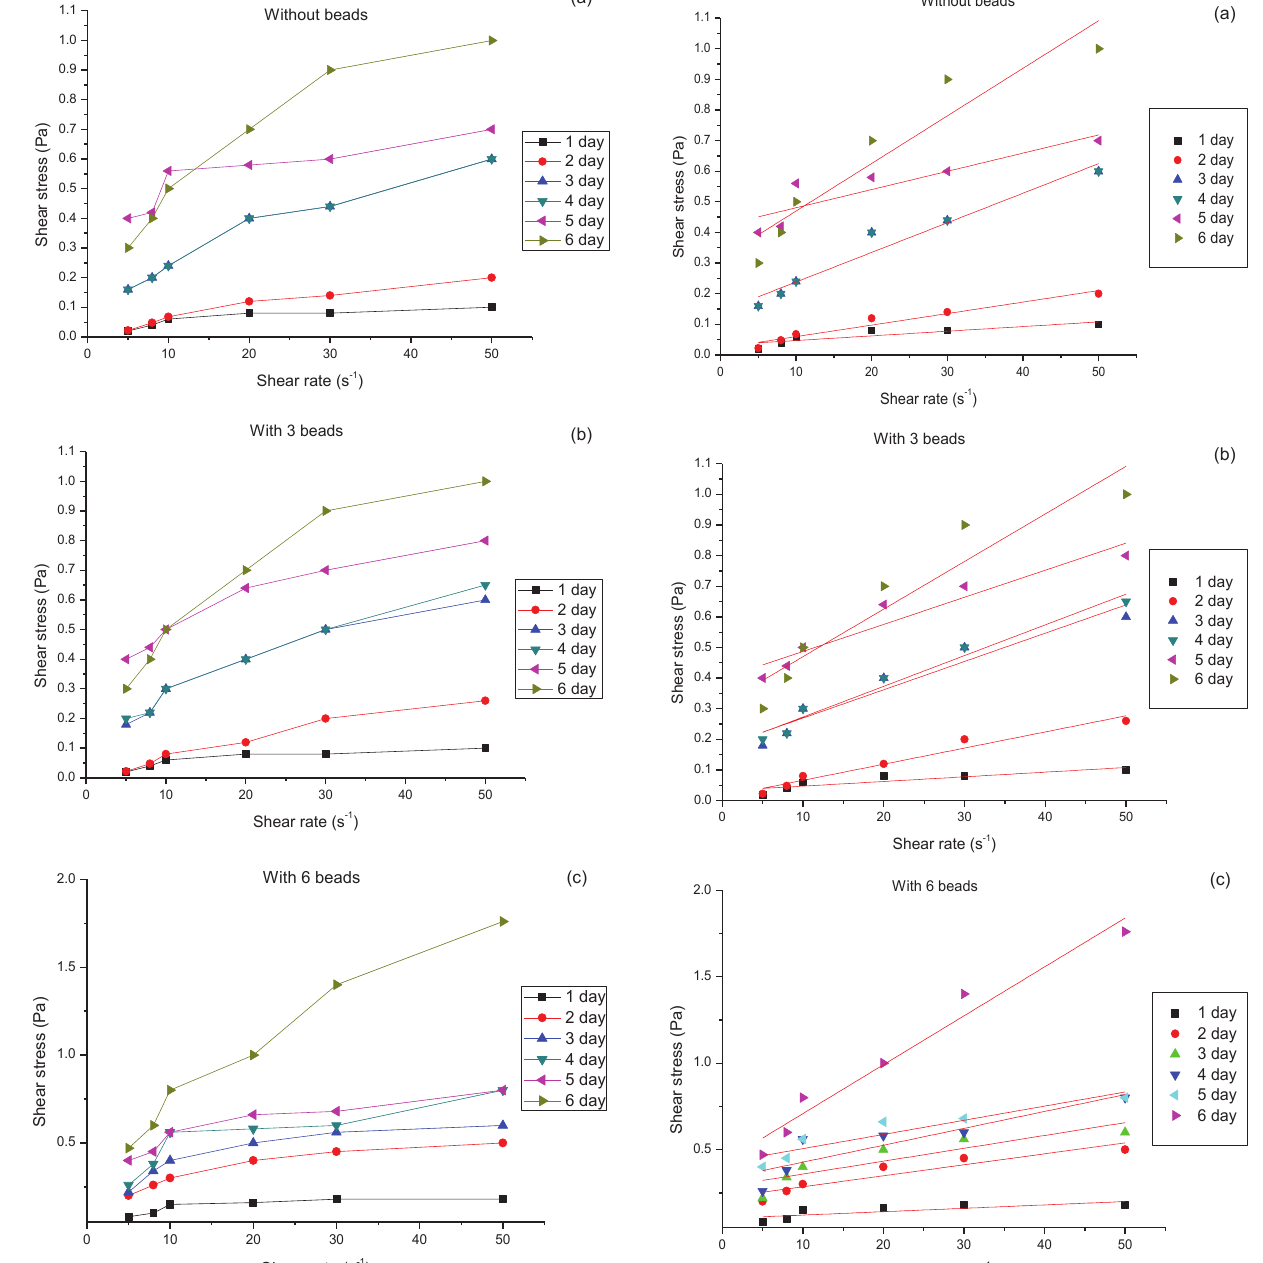
Fig. 2 – Rheological pattern of S. roseosporus when grown without beads (a), with 3 beads (b), and with 6 beads (c) in submerged culture broth